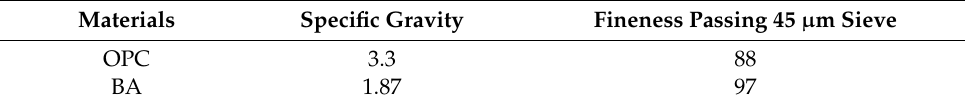
Table 2. Physical properties of OPC and BA.